Question: Generate an informative caption for the figure above.
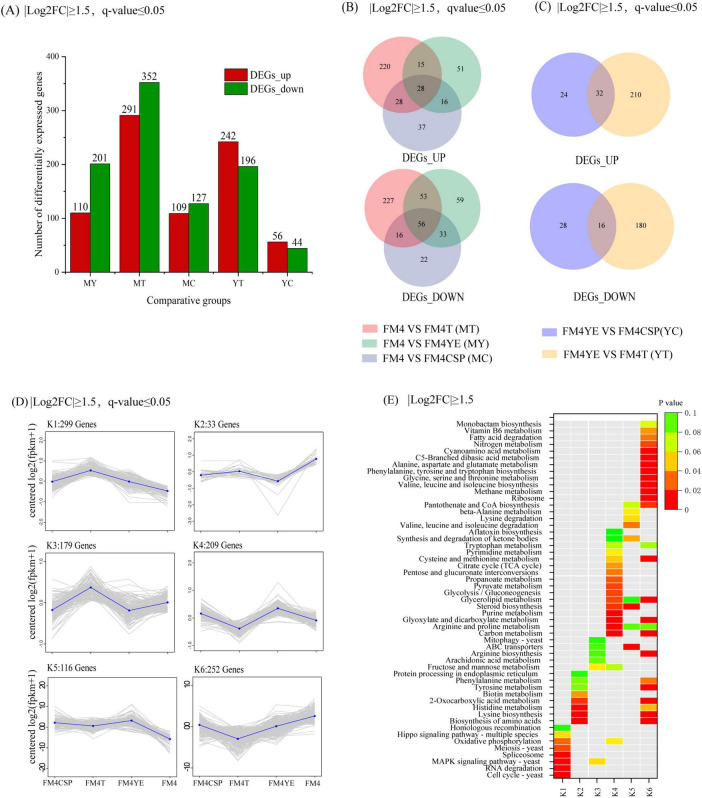
Answer: Differentially expressed genes (DEGs) profiles and co-expression analysis under different culture conditions. (A) Number of DEGs between media. (B) Venn diagram of DEGs comparing FM4 with organic nitrogen-supplemented media. (C) Venn diagram of DEGs in FM4Y versus FM4T and FM4Y versus FM4CSP. (D) Co-expression analysis showing clustering of DEGs into six clusters (K1–K6). (E) KEGG pathway enrichment of DEGs in each cluster. Organic nitrogen sources commonly downregulated energy-intensive amino acid biosynthesis, thereby alleviating metabolic burden under oxygen limitation.